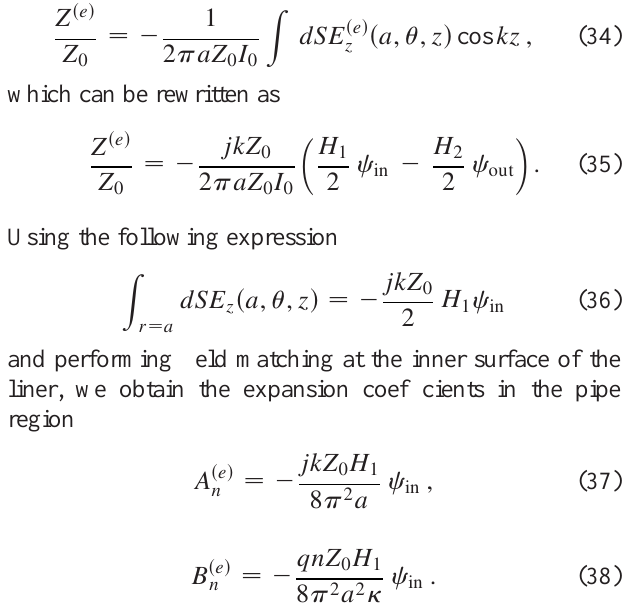
surface of the hole and by E 2 , H 2 near the outside